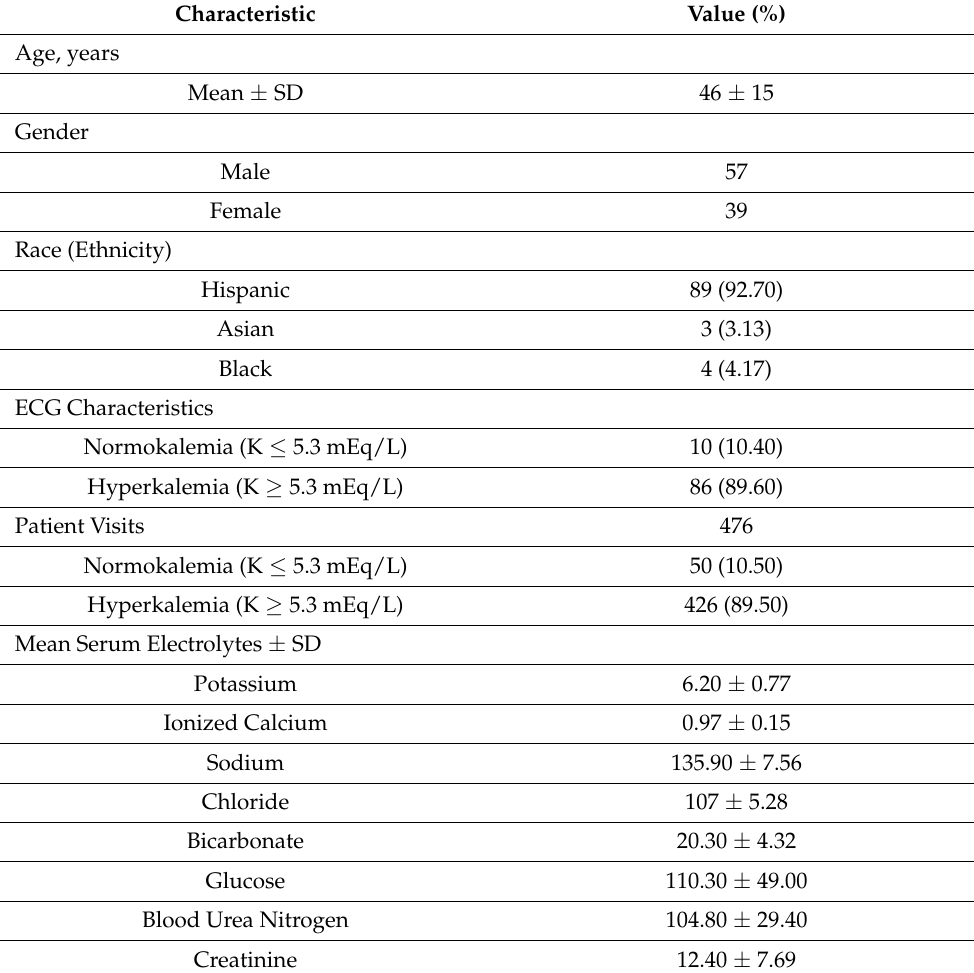
Table 1. Demographics, electrocardiogram (ECG) characteristics, and mean serum